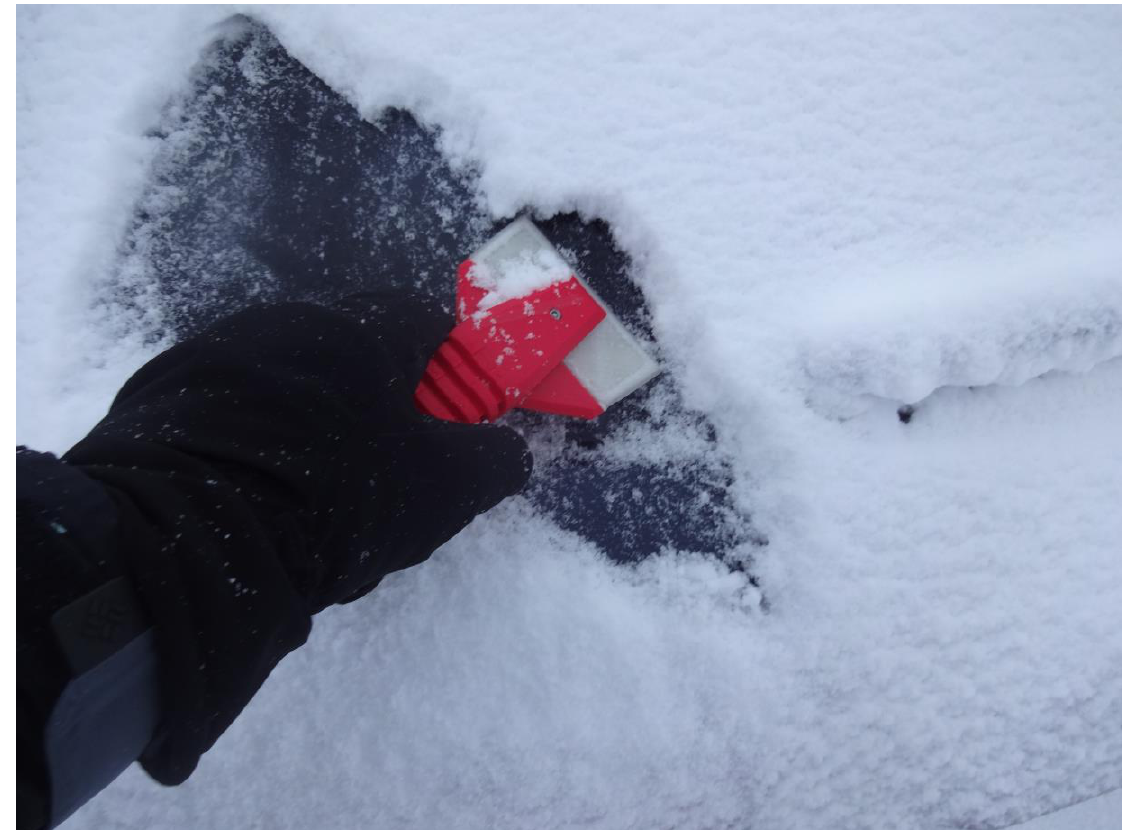
Figure 11. 3D-printed ice / snow scraper in use. The blade is recycled PC and the handle is polyactic acid (PLA).